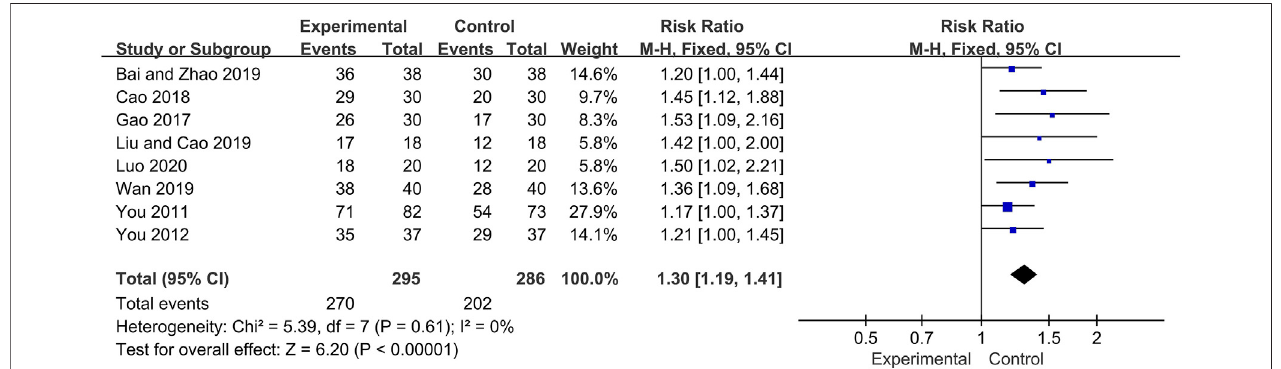
(SLEDAI scores: p (cid:1) 0.0003, I 2 (cid:1) 81%; TCM symptoms scores: p (cid:1) 0.04, I 2 (cid:1) 77%). The SLEDAI scores and TCM symptoms scores of